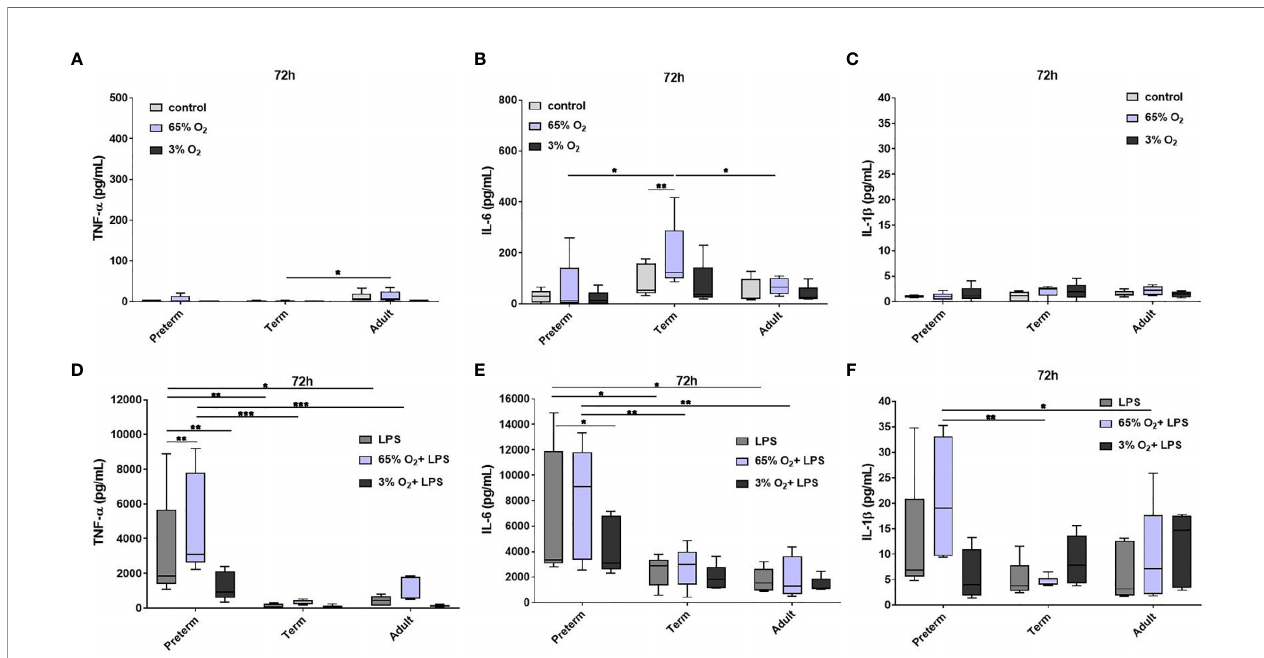
FIGURE 6 | Pro-in fl ammatory cytokine release in preterm, term and adult macrophages (M Ф ) primed with various O 2 concentrations followed by LPS. TNF a , IL-6, and IL-1 b release after O 2 exposure only compared to control (21% O 2 ) (A – C) and after priming with 65% O 2 or 3% O 2 followed by LPS compared to LPS alone (D – F) incubated for 72 h (48 h 65% O 2 or 3% O 2 followed by 24 h 21% O 2 with or without LPS). Cytokine release was measured in the supernatant of all three groups using a cytokine bead array (n=5 independent experiments with supernatants of fi ve different donors (same donors as Figure 2 72 h time point; control and LPS values were re-used from Figure 2 because oxygen and double-hit conditions were included in those experiments), box plots: median ± 25 th to 75 th percentiles and minimum to maximum, ANOVA followed by Holm-Sidak ’ s test, *p<0.05, **p<0.01, and